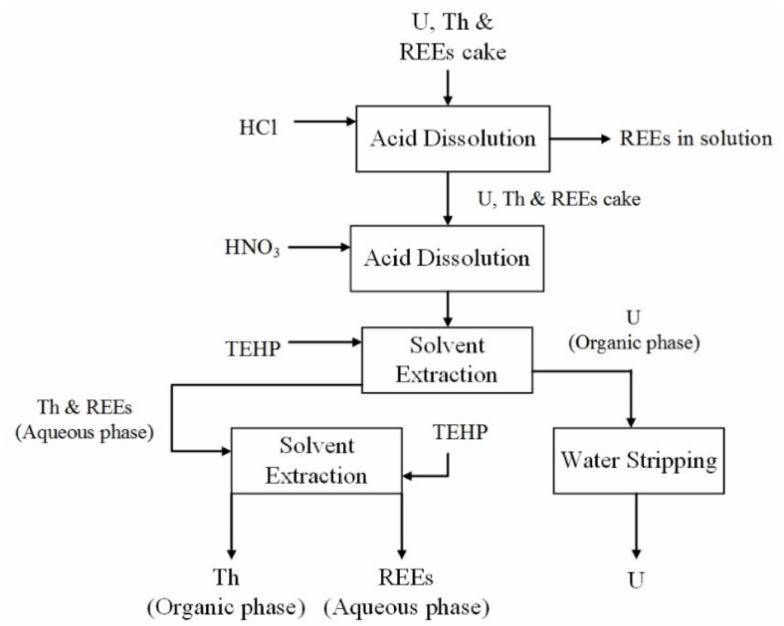
Figure 6. Separation of thorium and uranium from REE by solvent extraction method with TEHP in n-para ffi